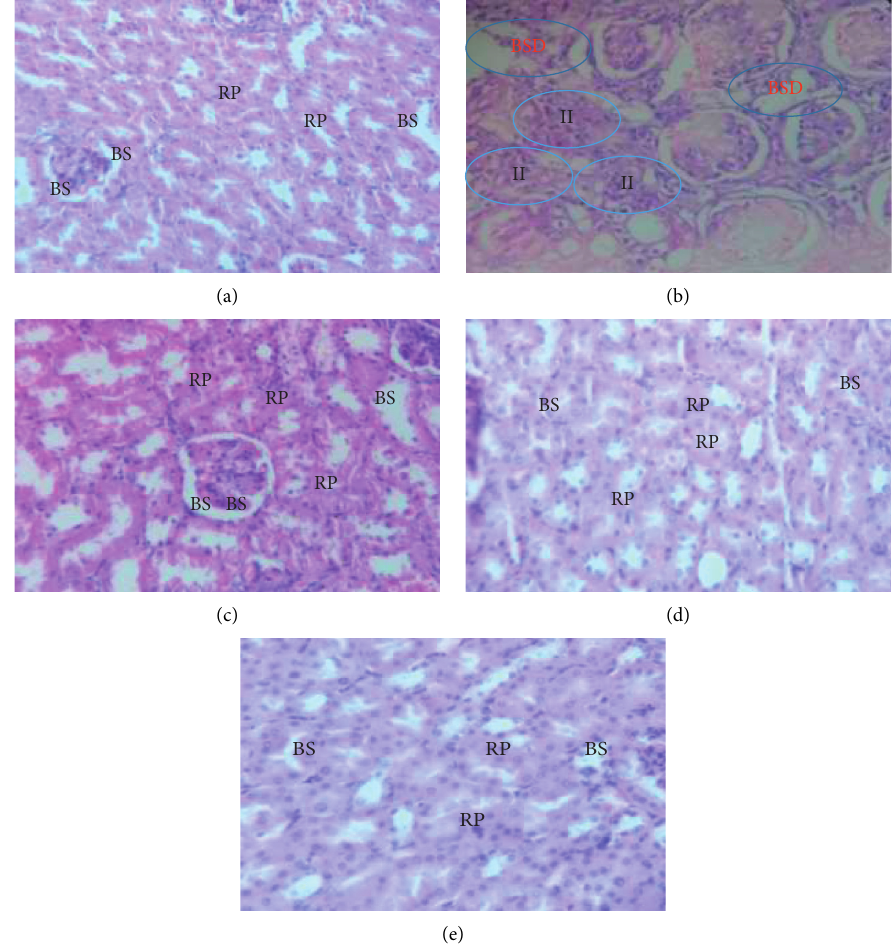
Figure 2: Photomicrograph of the kidney of experimental animals (40X, stained with hematoxylin and eosin): Group-I (a), Group-II (b), Group-III (c), Group-IV (d), and Group-V (e). BSD, Bowman’s space dilation; II, inflammatory infiltration; BS, Bowman’s space; RP, renal parenchyma.